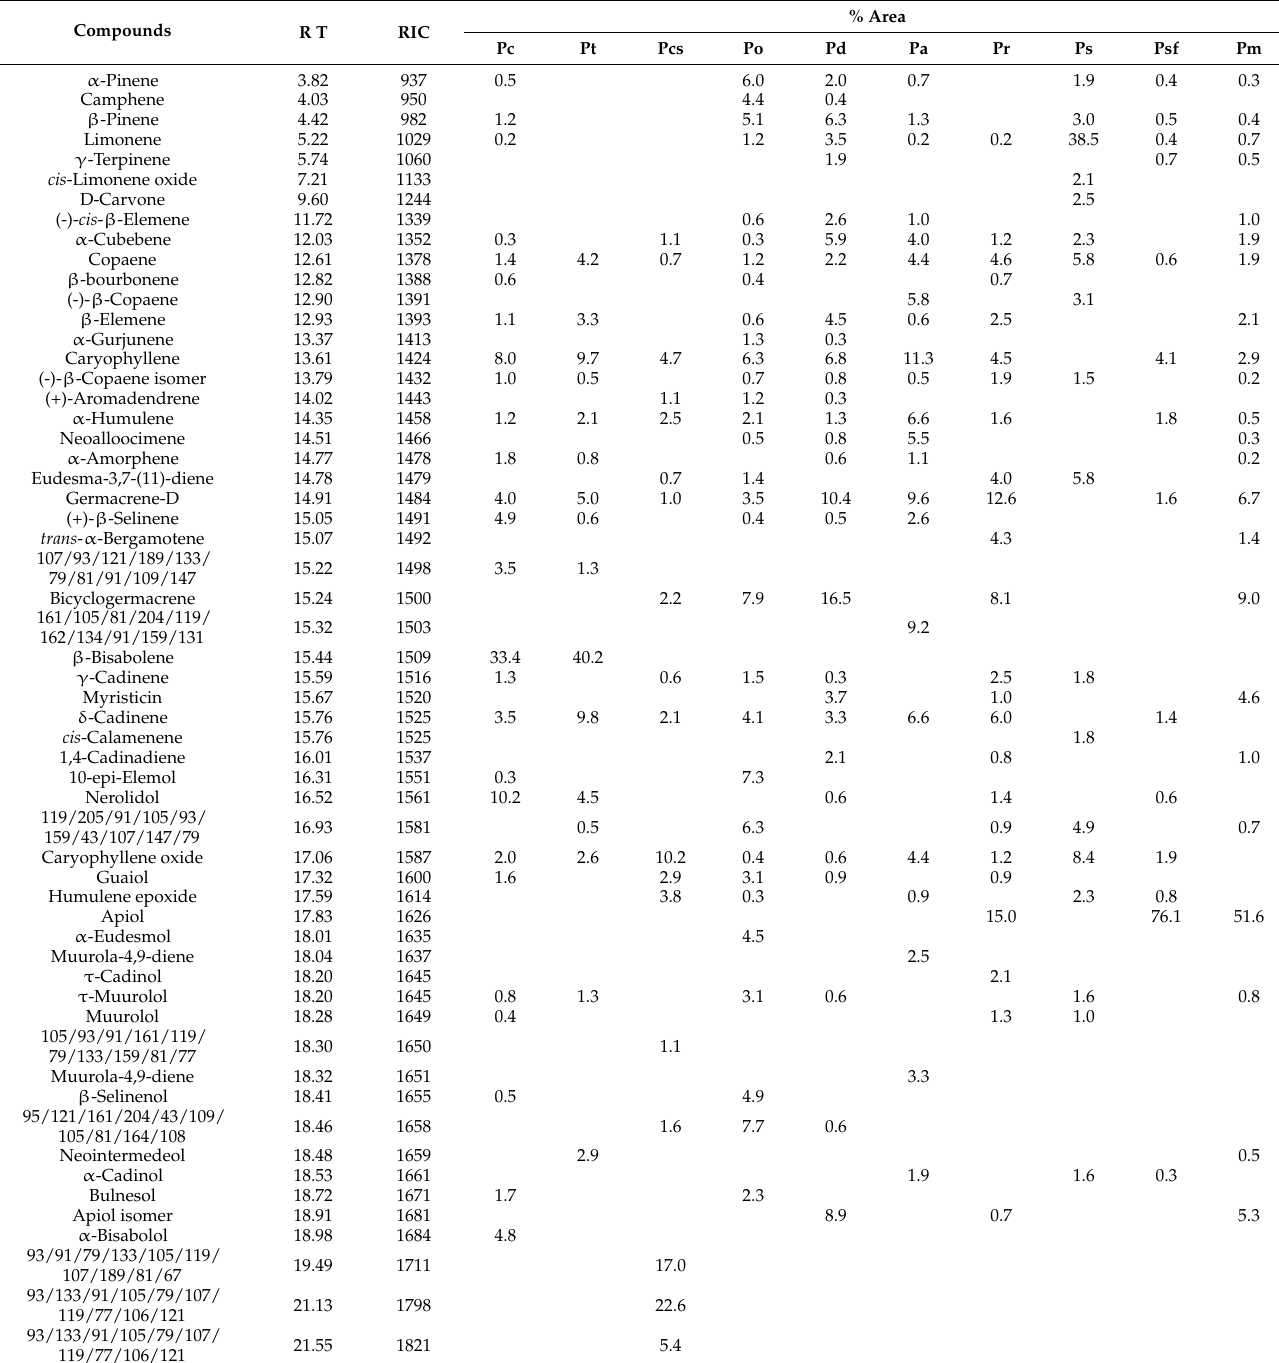
Table 1. Chemical composition of the essential oils from Piper coruscans (Pc), P. tuberculatum (Pt), P. casapiense (Pcs), P. obliquum (Po), P. dumosum (Pd), P. anonifolium (Pa), P. reticulatum (Pr), P.